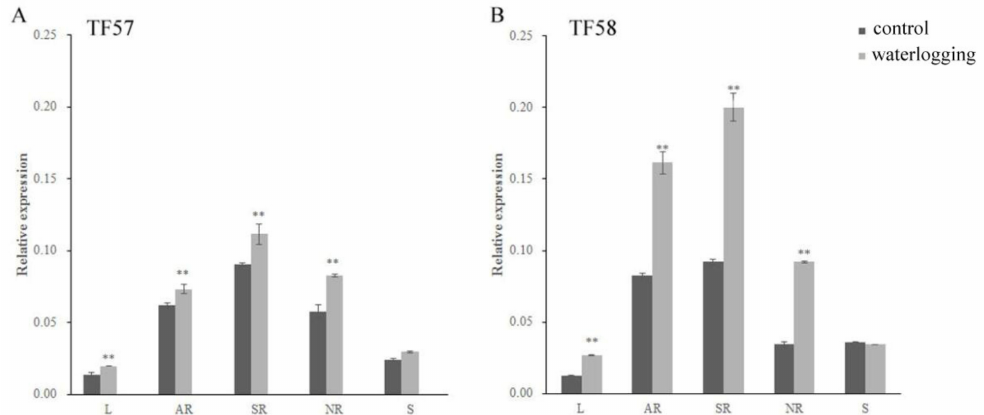
Figure 4. Expression levels of HvERF2.11 gene in TF57 and TF58, RT-PCR analysis of transgenic and wild-type plants. ( A ) Expression levels of the HvERF2.11 gene under waterlogging stress in di ff erent organs of TF57. Results are the mean ± SD. * and ** represent the significant di ff erences at p < 0.05 and p < 0.01, respectively. ( B ) Expression levels of the HvERF2.11 gene under waterlogging stress in di ff erent organs of TF58. The mean value and standard deviation were obtained from three independent experiments. The data represent mean ± SD of three biological repeats with three measurements per sample. * and ** represent the significant di ff erences at p < 0.05 and p < 0.01, respectively. L: leaf;